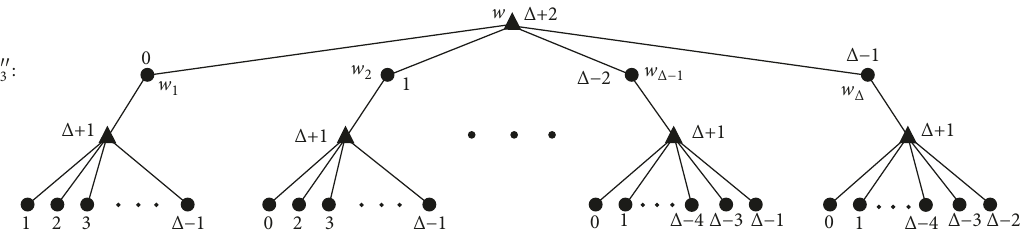
Figure 6: Irreducible 𝐿(2,1) -span coloring of 𝑇 󸀠󸀠 3 with one hole.